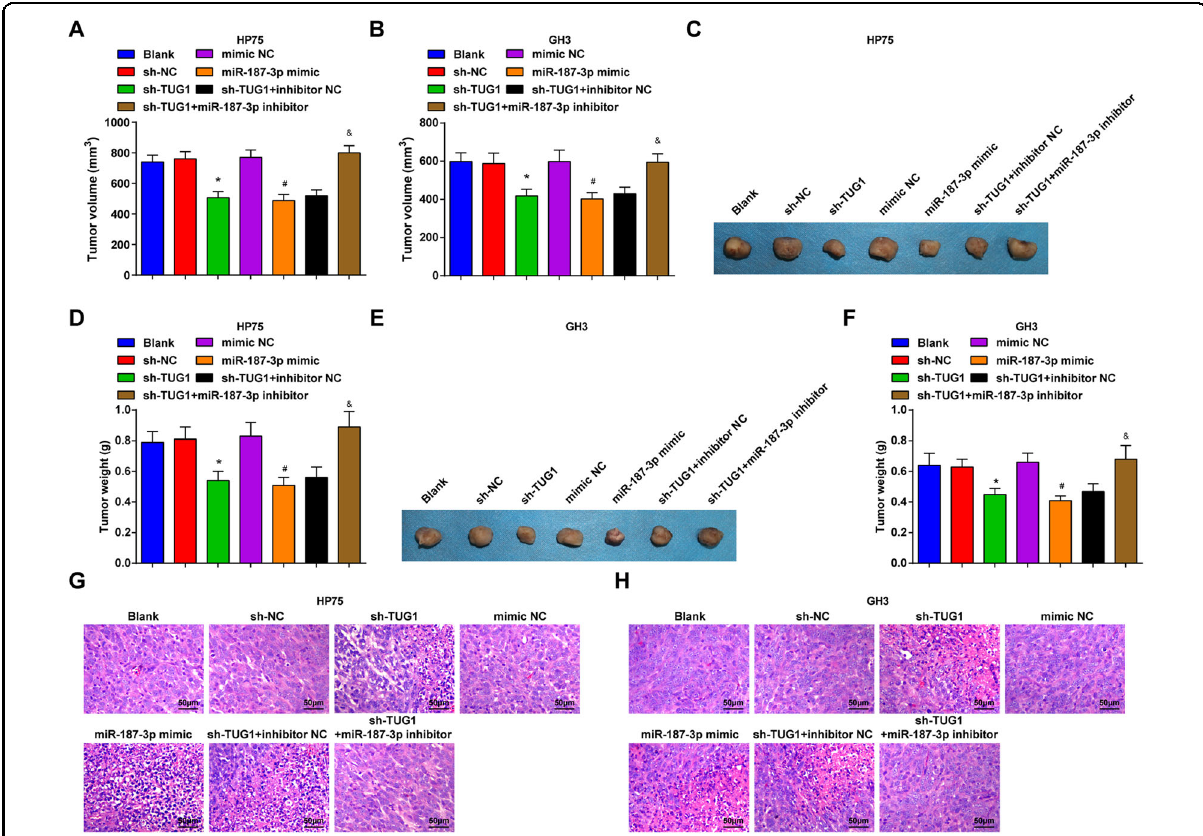
Fig. 7 Inhibited TUG1 or elevated miR-187-3p restrains tumor growth of PA in vivo. A Tumor volume of nude mice that have been injected with HP75 cells on the 24th day; B Tumor volume of nude mice that have been injected with GH3 cells on the 24th day; C representative tumors fi gures of nude mice that have been injected with HP75 cells on the 24th day; D tumor weight of nude mice that have been injected with HP75 cells; E representative tumors fi gures of nude mice that have been injected with GH3 cells on the 24th day; F tumor weight of nude mice that have been injected with GH3 cells; G pathological changes in xenografts from nude mice after injection of HP75 cells observed using HE staining; H pathological changes in xenografts from nude mice after injection of GH3 cells observed using HE staining; n = 5 mice. Data are presented as mean ± SD. * P < 0.05 vs the sh-NC group, # P < 0.05 vs the mimic NC group, & P < 0.05 vs the sh-TUG1 + inhibitor NC